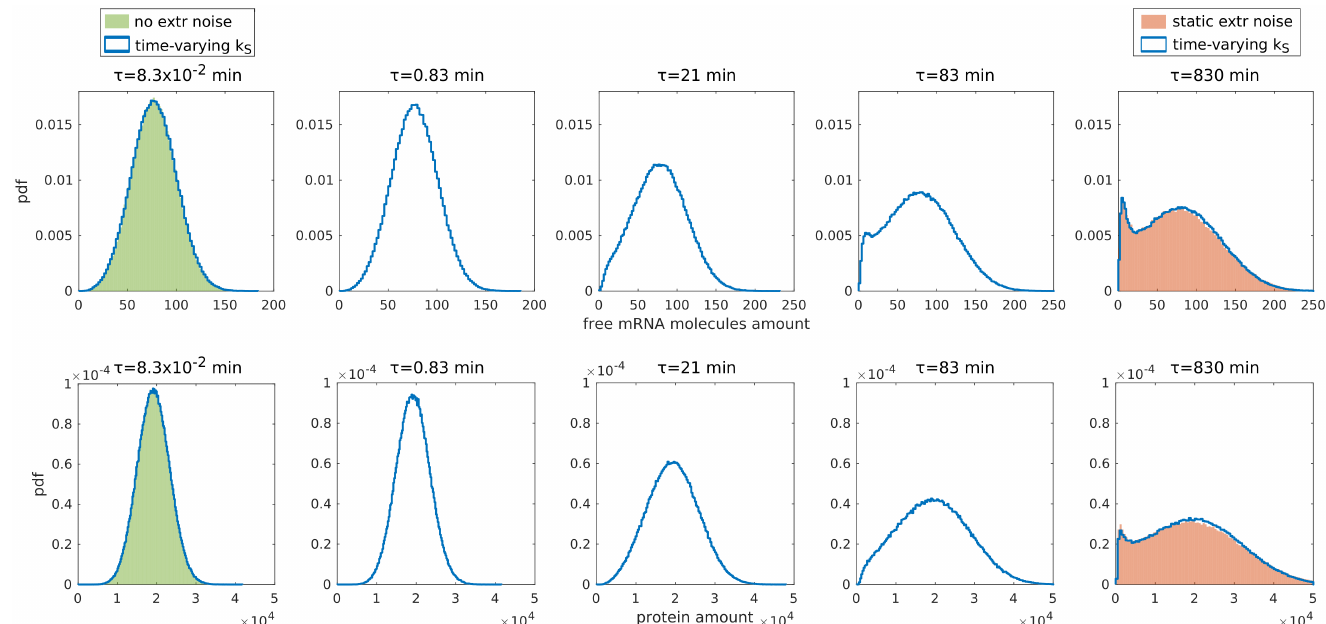
Fig 8. Bimodality appearance in presence of time-dependent extrinsic noise. Solid cyan lines represent free mRNA molecules distributions with a time-dependent extrinsic noise on the miRNA transcription rate k . The transcription rate is coupled to a birth and death process with finite pool N = 100. The steady-state S distribution of k S is a nearly Gaussian distribution with mean (cid:22) k ¼ 1 : 2 (cid:2) 10 (cid:0) 3 nM min (cid:0) 1 and standard deviation σ = 2.4 × 10 −4 nM min −1 . The time scale of this S process is tuned by changing the values of the birth and death rates, keeping their ratio fixed. The time scales of the fluctuations of the miRNA transcription rate, from left to right are: 8.3 × 10 −2 min, 0.83 min, 21 min, 83 min and 830 min. The green histogram in the leftmost plot represents the free mRNA molecules distribution in absence of extrinsic noise. The orange histogram in the rightmost plot represents the free mRNA molecules distribution with static extrinsic noise introduced as described in the main text; the k S distribution used in this case is a Gaussian with mean (cid:22) k ¼ 1 : 2 (cid:2) 10 (cid:0) 3 nM min (cid:0) 1 and standard deviation σ = 2.4 × 10 −4 nM min −1 . S All the free mRNA molecules distributions are obtained from numerical simulations. The parameters are k = 3.1 × 10 −3 nM min −1 , g = 2.4 × 10 −2 min −1 , g R R S